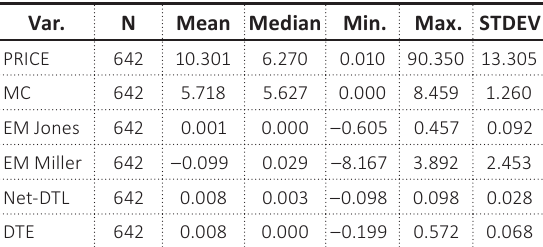
Table 4. Outer weights